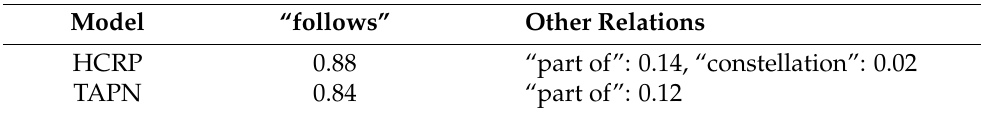
Figure 5. The accuracy of our proposed TAPN method and the best baseline HCRP on each test relation. Table 7. The error source of relation